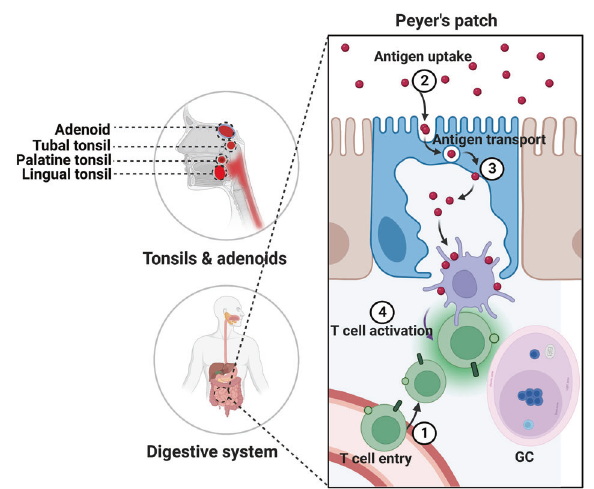
Fig. 5 Potential sites for induction of immune response induced by oral-delivered viral vector vaccine. In the oral cavity, viral vector vaccines enter through oral lymphoid tissue, including adenoid, tubal tonsil, palatine tonsil, and lingual tonsil, etc. In the small intestine, Peyer ’ s patch is the core site for immune response (1) T cells enter Peyer ’ s patch from blood vessels. (2) M cells take up antigens by endocytosis and phagocytosis. (3) Antigens are transported across the M cell in vessels and released at the basal surface. (4) T cells in the Peyer ’ s patch encounter antigens and are activated by dendritic cells. (Created in